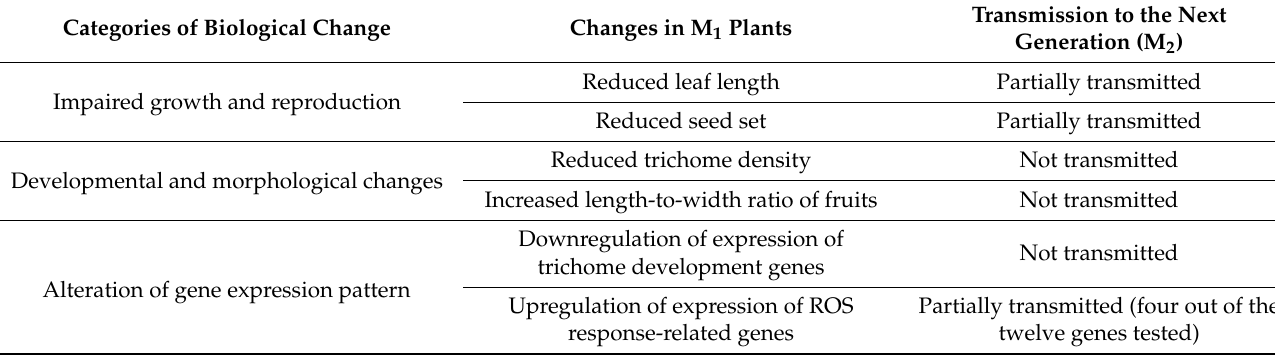
Transmission to the Next Generation (M 2 )